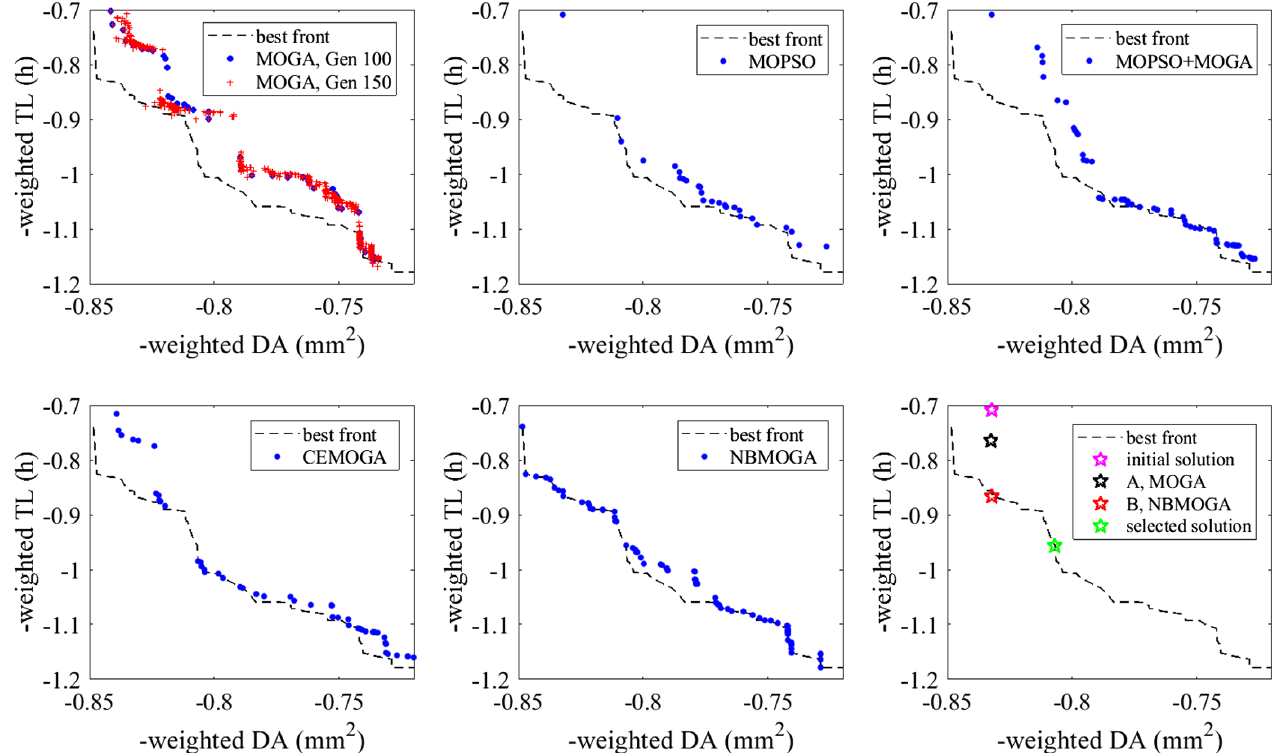
FIG. 11. Comparison of the nondominated solutions in the 100th generation obtained with different optimization methods. The black dashed line represents the best front. The pink star is the initial solution. The black and red stars, A and B, are two nondominated solutions of standard MOGA and NBMOGA, respectively, which have almost the same DA area as the initial solution. The green star is the selected solution for the multipole strengths of the HEPS.